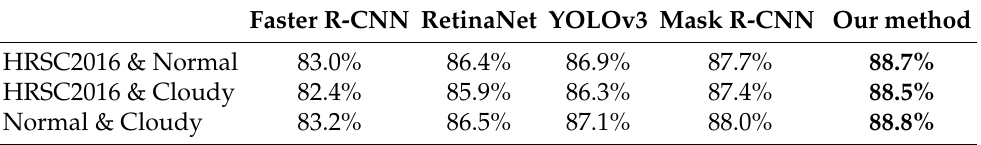
Table 5. Quantitative comparison results on synthetic remote sensing